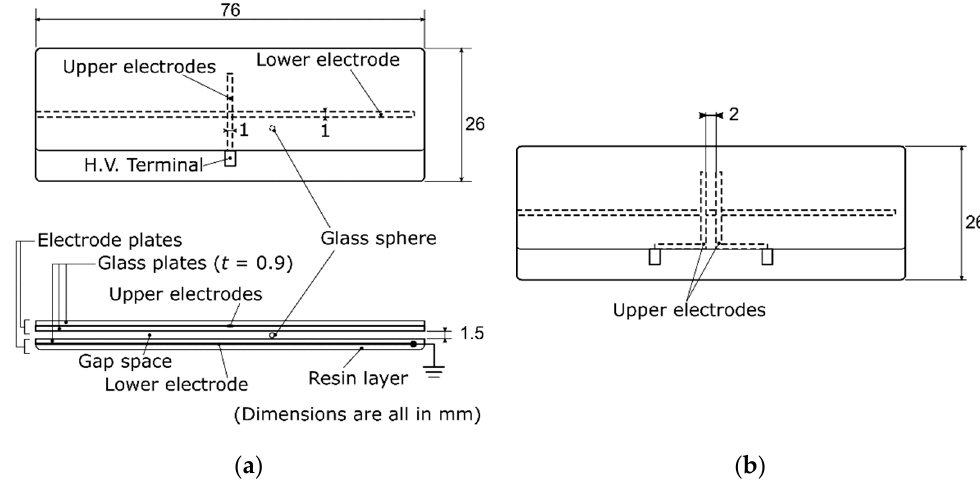
Figure 2. Manipulation device tested: ( a ) Top and side views of a set of electrode plates of single- cross-point type; ( b ) Top view of an electrode plate of dual-cross-point type.